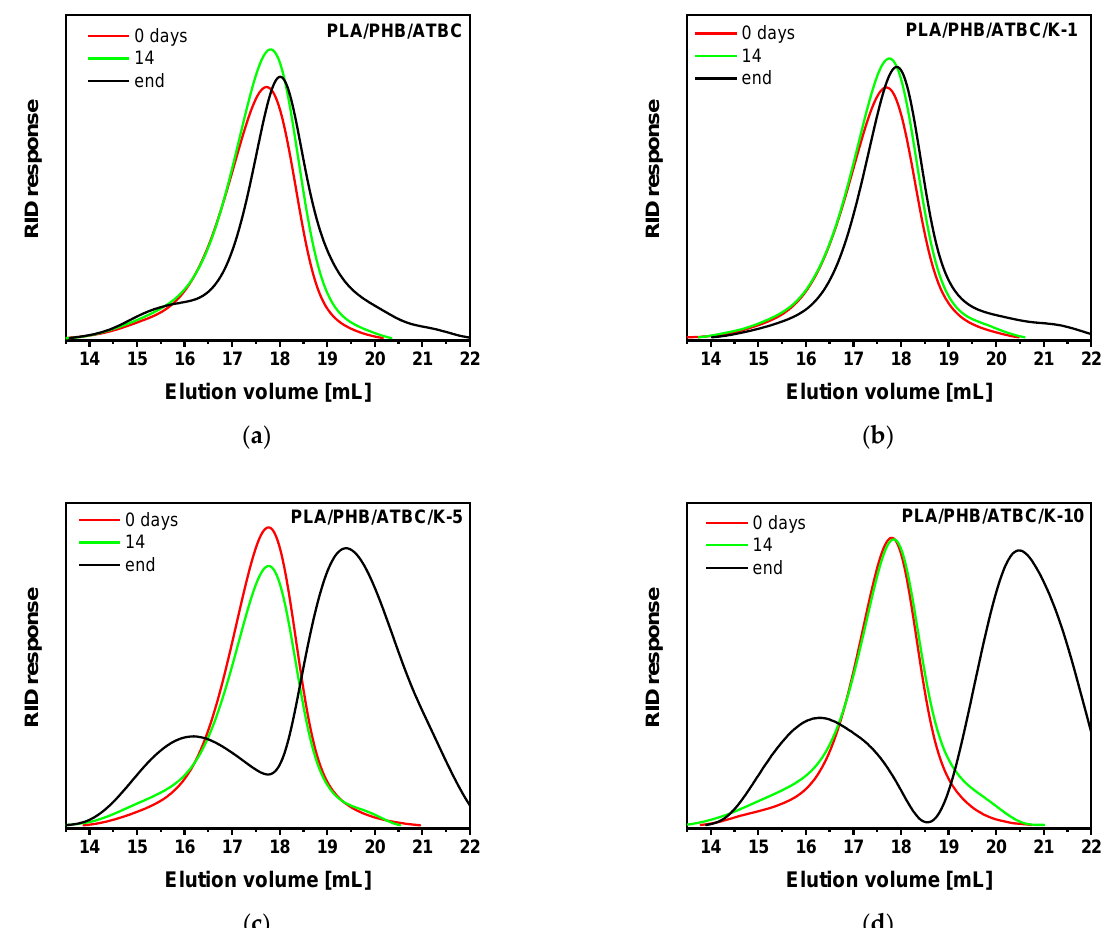
Figure 8. GPC traces of PLA/PHB/ATBC blend ( a ) and its keratin composites with 1 wt% ( b ), 5 wt% ( c ) and 10 wt% ( d ) before hydrolysis, after 14 days and at the end of hydrolysis in 0.01 M NaOH.